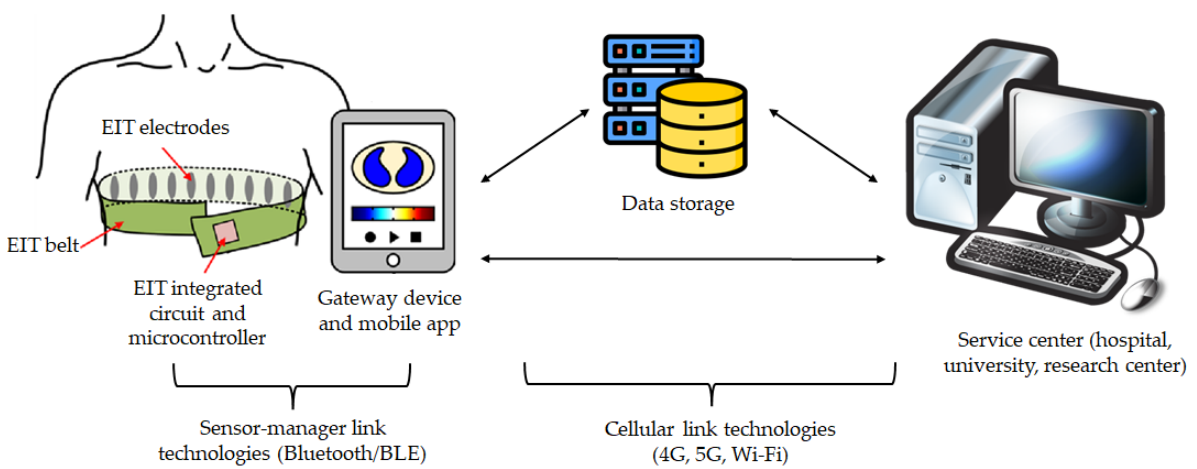
Figure 3. Telemedicine system with EIT device following the two-hop architecture; adapted from [115,116]. The EIT electrodes are connected to the microcontroller and other components; all these elements are placed on a belt. Data are sent via sensor-manager link technologies, such as Bluetooth, to a gateway device, generally a smartphone or tablet. A mobile app can be installed on the gateway device for real-time image visualization. The gateway device sends data via cellular link technologies to a central database (data storage), and results can be accessed from a remote service center.